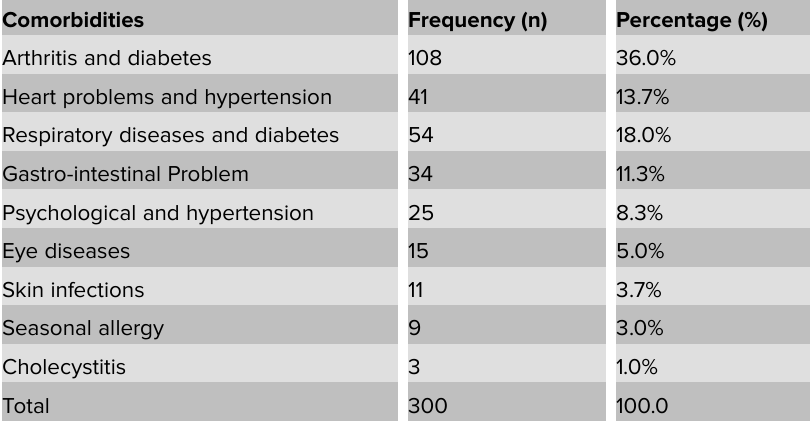
TABLE 2: Comorbidities among